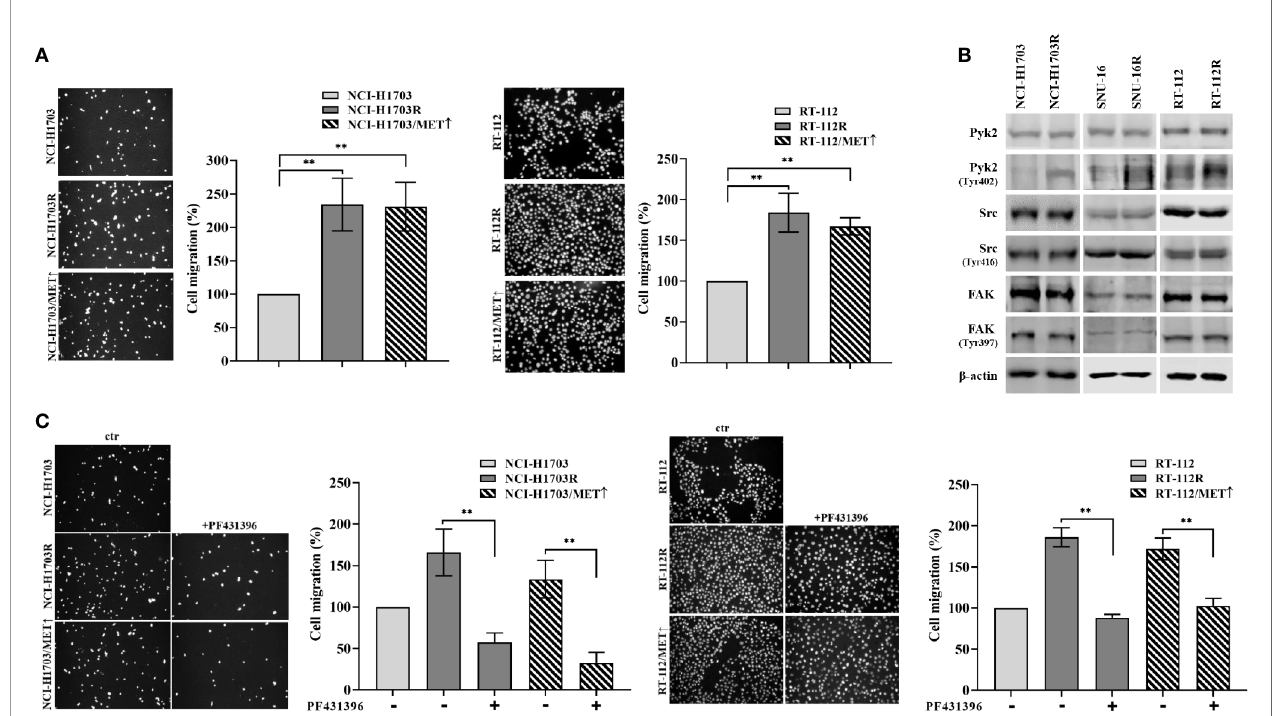
FIGURE 5 | CPL304110-resistant cells exhibit promigratory abilities. (A) Parental, CPL304110-resistant, and MET-overexpressing cell variants migrated towards full medium. Data are expressed as mean ± SD, **p ≤ 0.01, n = 3. (B) Western blot analysis was performed with lysates from parental and resistant cells to assess phosphorylation levels of Pyk2, Src, and FAK. Experiments were conducted in triplicates. (C) The Pyk2 inhibitor PF431396 (100 nM) reduces the migratory abilities of resistant and MET-overexpressing cell variants. Data are expressed as mean ± SD, **p ≤ 0.01, n =